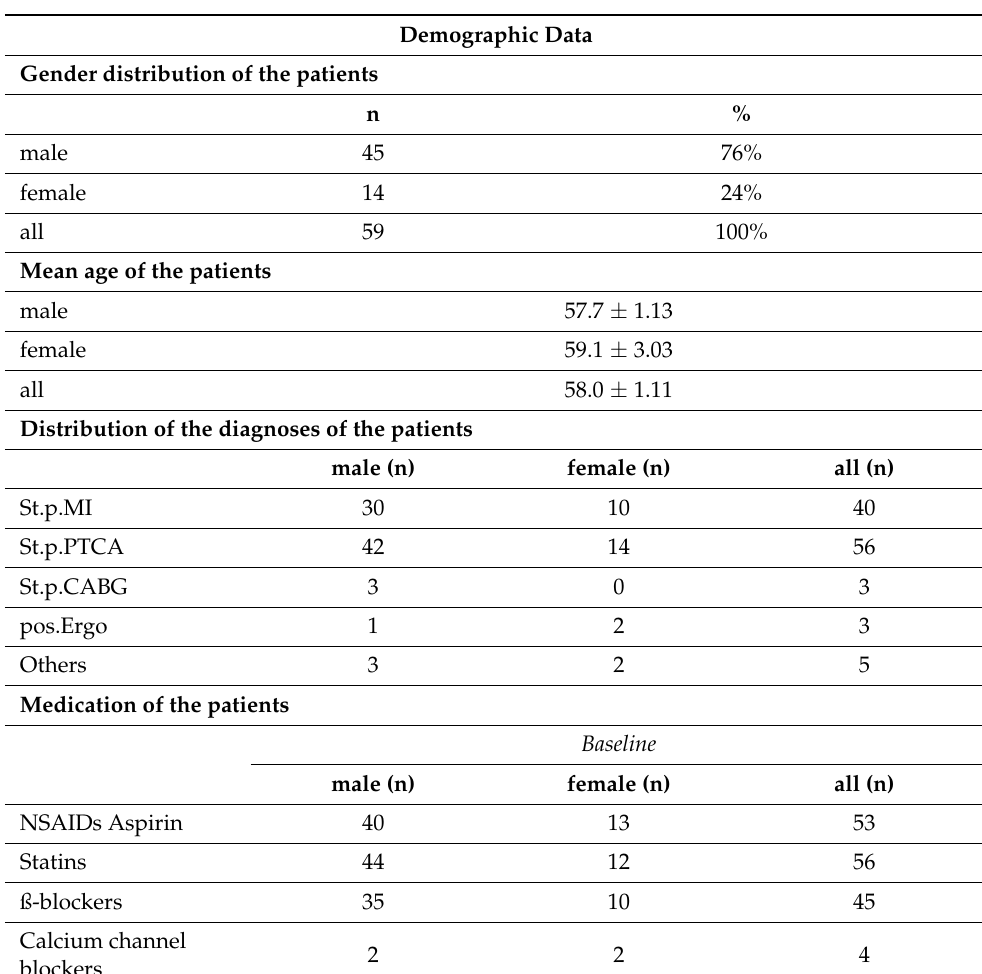
Table 1. Summary of the demographic data. Gender distribution, mean age of the patients (mean ± SEM), distribution of diagnosis and medication at baseline (T 0 ) are given. Some patients had multiple diagnoses. Myocardial infarction (Status post MI), percutaneous coronary intervention (St.p. PTCA), coronary artery bypass graft (St.p.CABG), positive ergometry (pos.Ergo) and nonsteroidal anti-inflammatory drugs (NSAIDs). Demographic